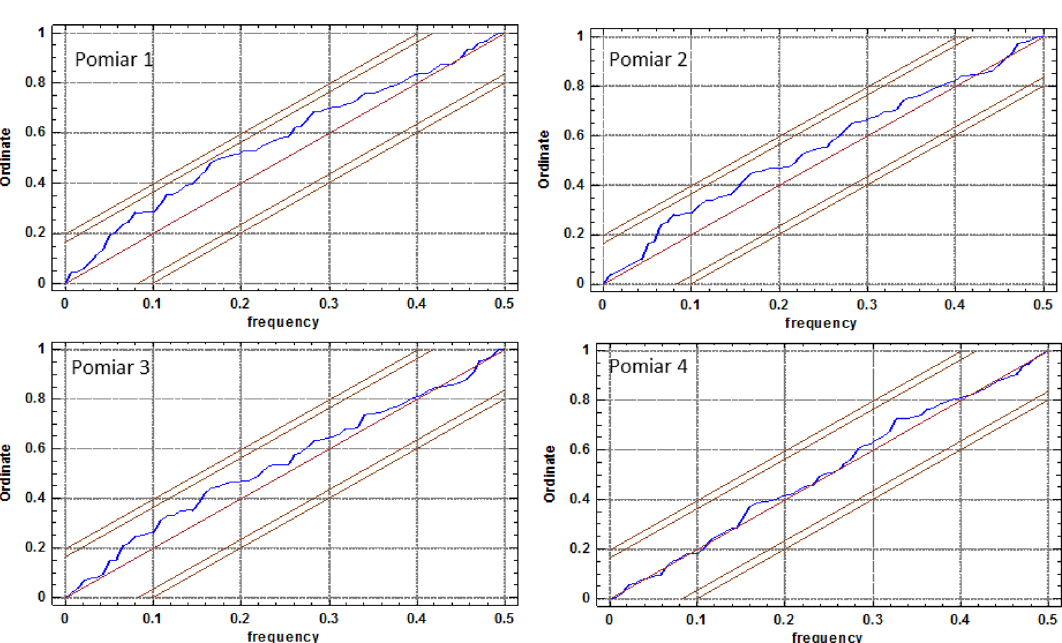
Figure 15. Integrated periodogram for the number of defects (density) in 1-m segments of the 7–8 belt section along its axis for consecutive scans 5,42 [Statgraphics Centurion Version 18.1.06 64-bit version (academic license of Wrocław University of Science and Technology), https:// www. statg raphi cs.